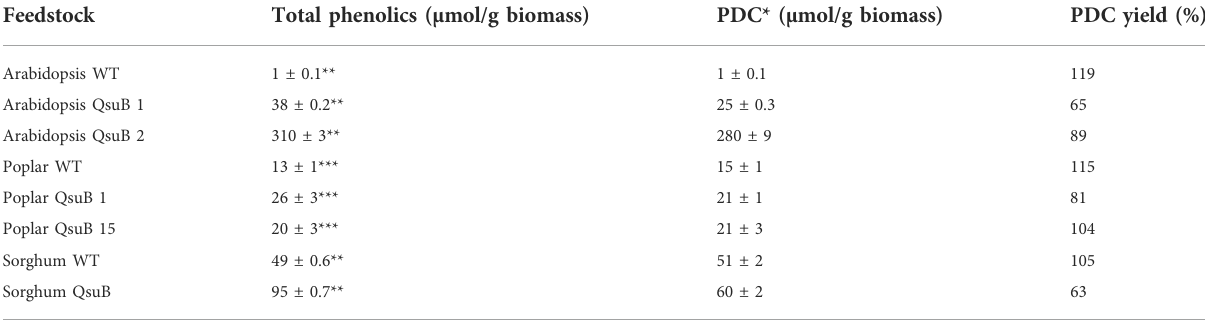
TABLE1Totalphenolics atbeginning ofmicrobial incubations, normalized bydryweight ofbiomasstreated, andPDCproduced,bothnormalized by biomass treated and as yield from total phenolics.